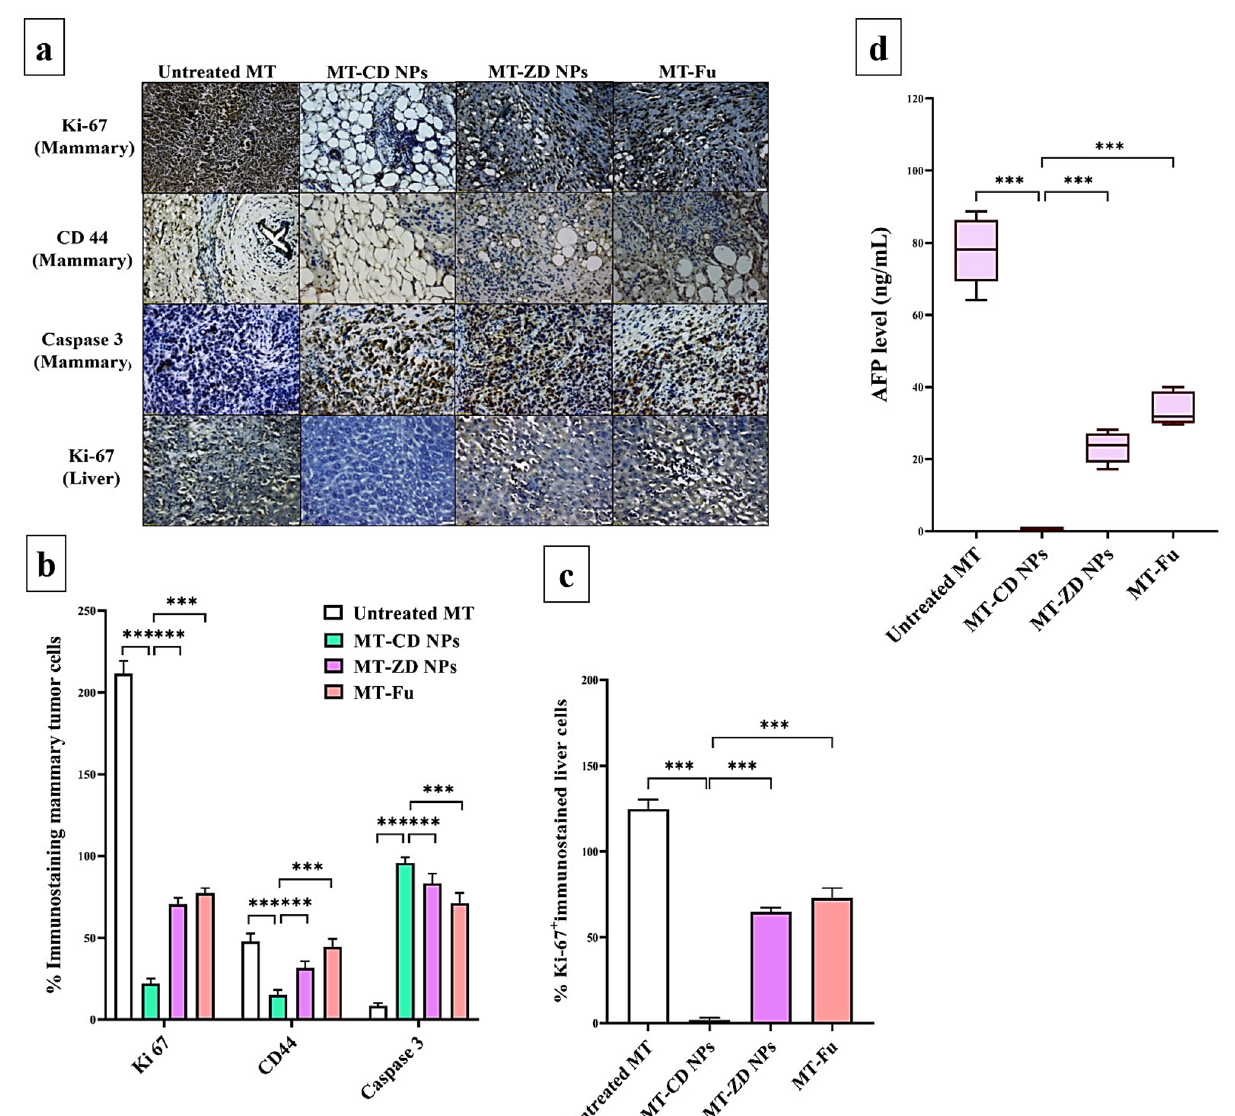
Figure 5. Immunohistochemical analysis and biochemical detection of anti-metastatic tumor potential. ( a ) Microscopic images of Ki-67, CD44, and caspase 3-immunostained mammary tumor as well as Ki-67- immunostained liver sections of the untreated mammary tumor-bearing mouse group (MT), CD NPs-treated MT group (MT-CD NPs), MT-ZD NPs group, and MT-Fu group with ( b,c ) their percentages of positive immunostained tumor cells. ( d ) The blood level (ng/mL) of α-fetoprotein (AFP). All values are demonstrated as mean ± SEM. MT-CD NPs group was compared to other groups, considering significantly different at p < 0.05*, < 0.01**, and <